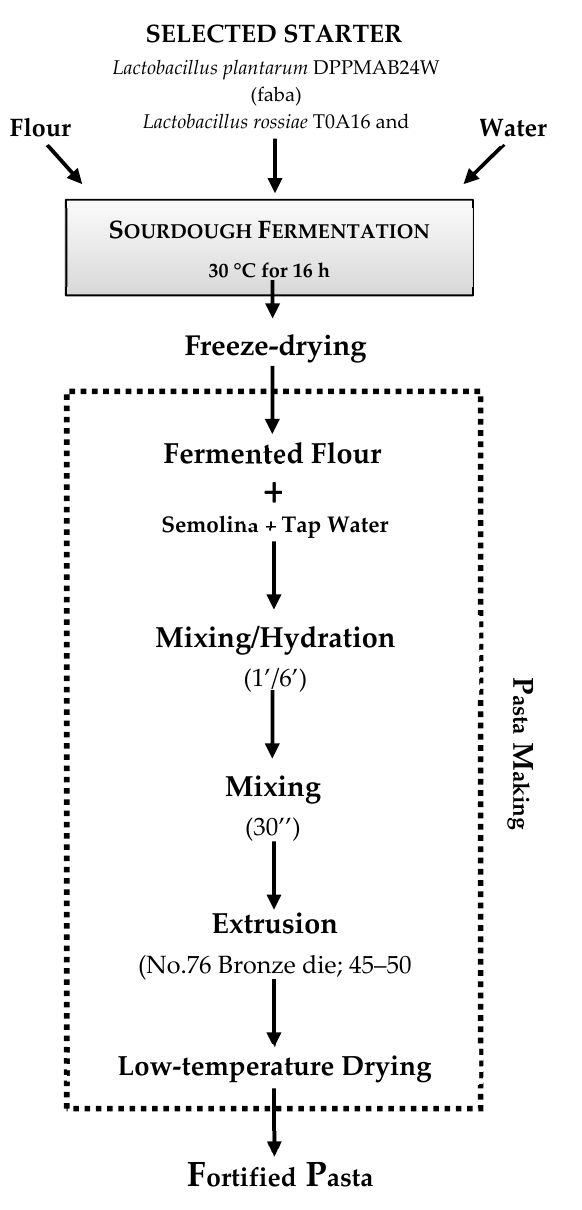
Figure 1. Example of the production process of pasta fortified with faba bean [51] or quinoa [80] flours fermented with selected lactic acid bacteria.